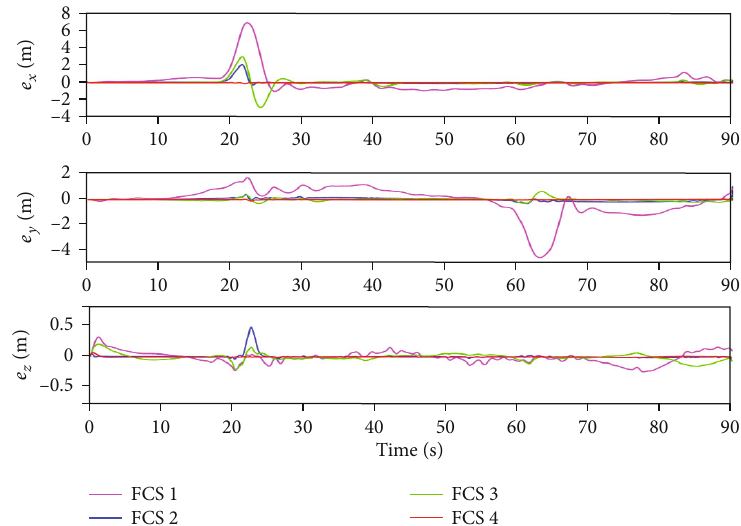
Figure 7: Evolution of the tracking errors for the translational subsystem ð e